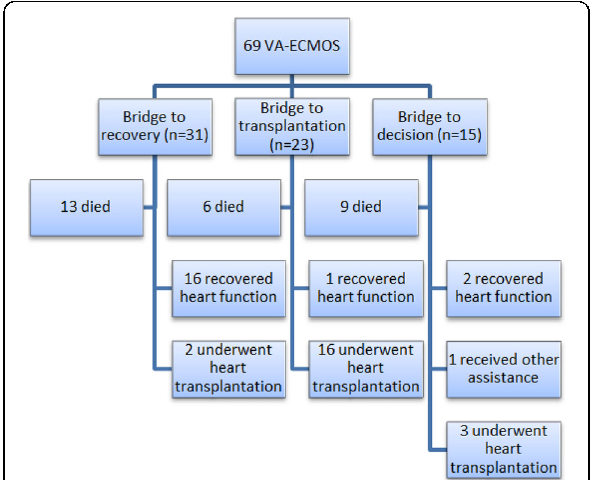
Fig. 2 (abstract 0331). VA-ECMOs